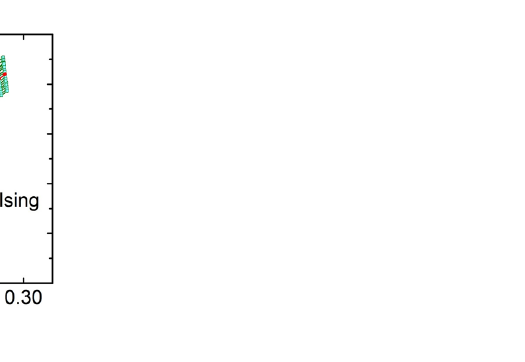
Figure 6. Isotherms of M 2 vs. µ 0 H/M for 94 K ≤ T ≤ 111 K ( | ǫ | ≤ 0.1 ) with the short-range 2D-Ising model. (The figure has been drawn using OriginPro 2015